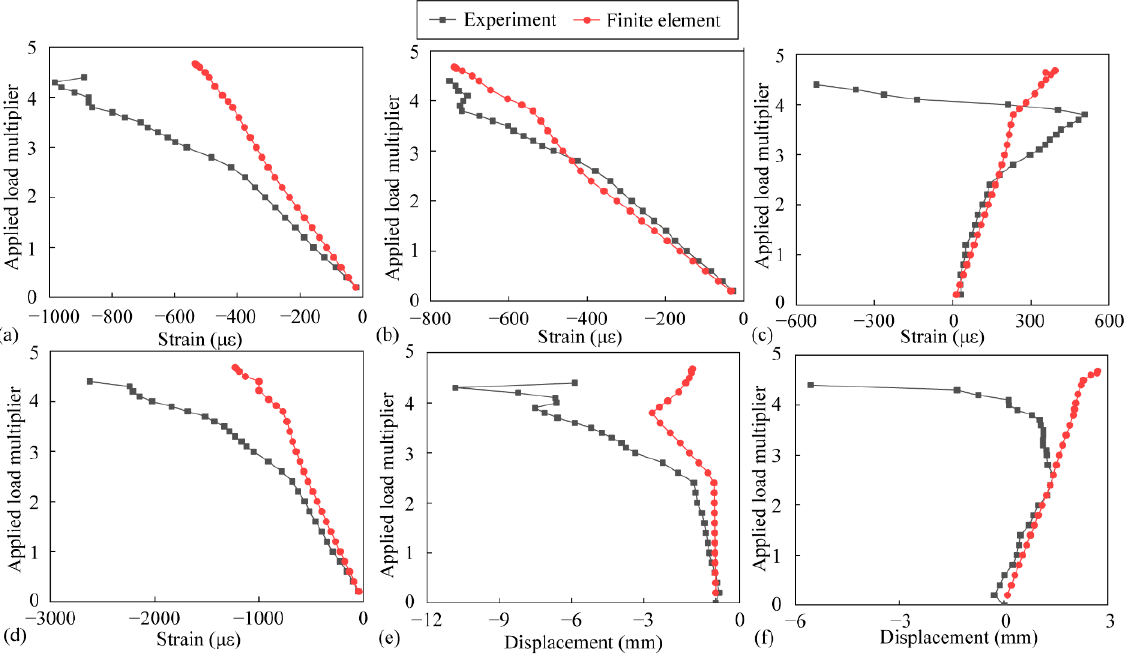
Figure 8. Comparative plots of strains at the ( a ) a and ( b ) b sections, ( c ) first principal strain and ( d ) principal strain at the c section, and displacement of juncture node in the ( e ) horizontal and ( f ) vertical